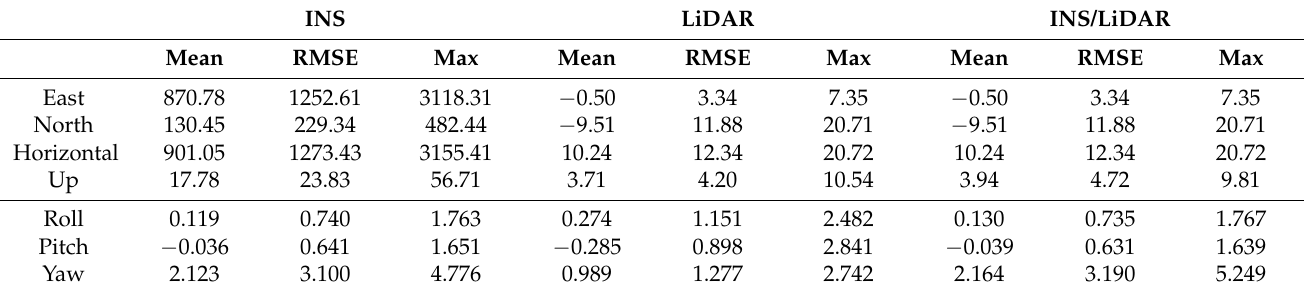
Table A1. D-18—position (m) and attitude (deg) error